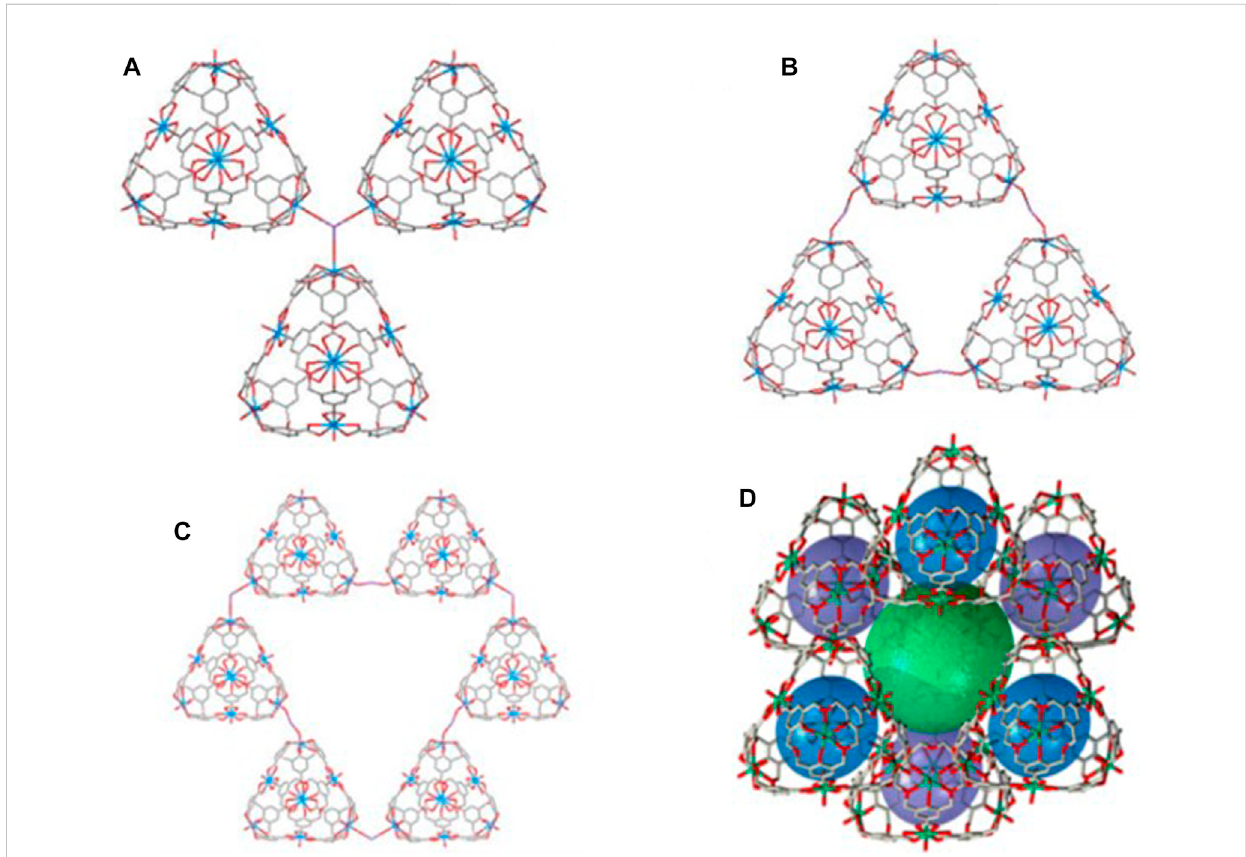
FIGURE 4 Stacking mode between tetrahedral cages and bridged potassium counterions in C2 . (A) Each potassium bridges three tetrahedral cages. (B) Three tetrahedra form a circle via three bridged potassium cations. (C) Six tetrahedra in a circle via six bridged potassium atoms. (D) Self-assembled cavity (in green) formed by six tetrahedral cages with a ca . 882 Å 3 volume.